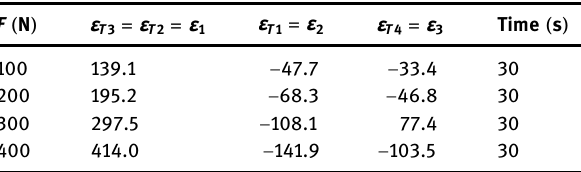
Table 5: Results of strain gauge measurement of samples K20 with